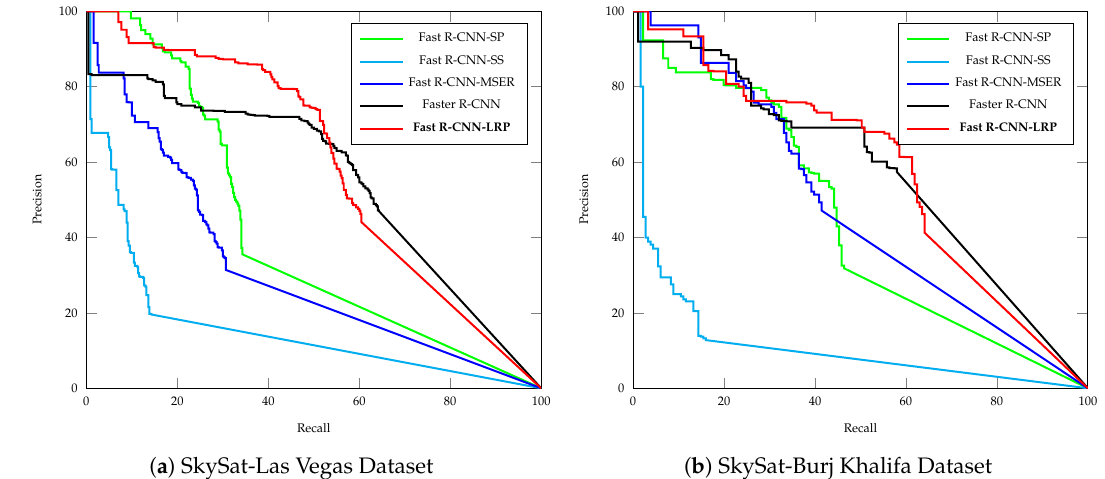
Figure 11. Precision-recall